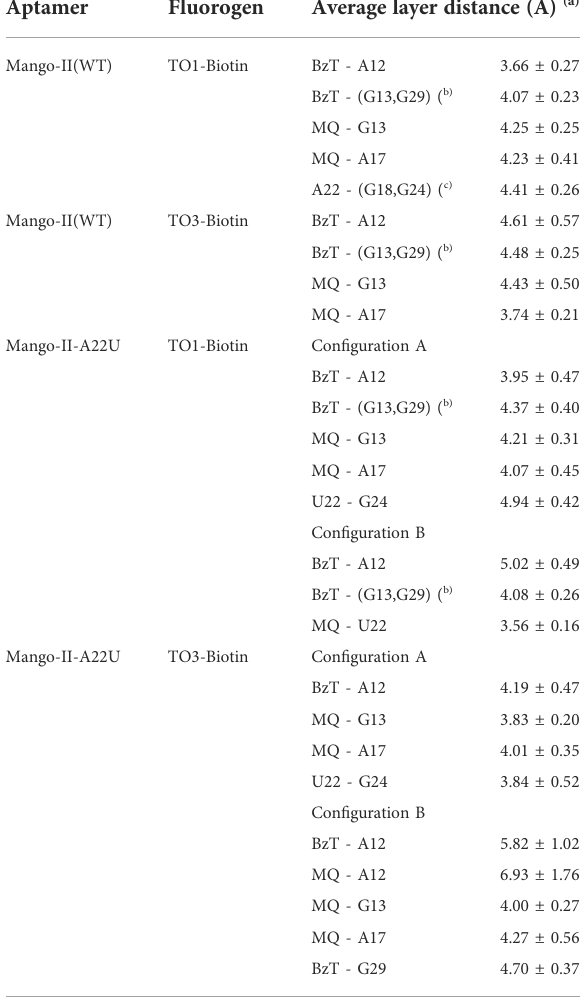
TABLE 1 Binding modes and structural data of aptamer- fl uorogen complexes from MD simulations. Aptamer